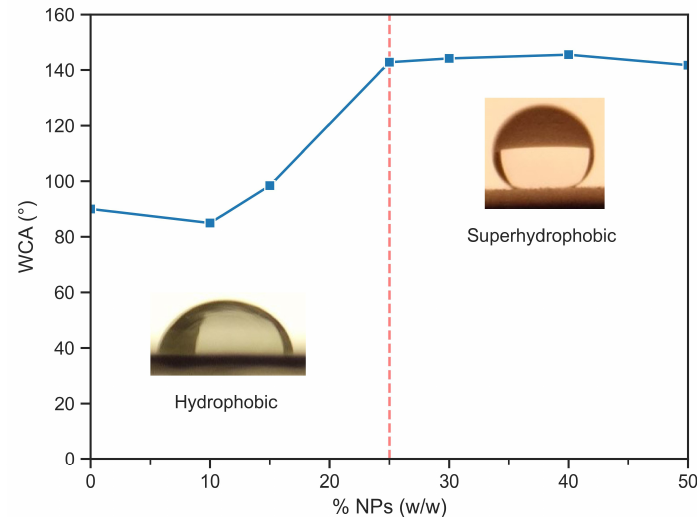
Figure 6. WCA in a flat surface for different concentrations of NPs.